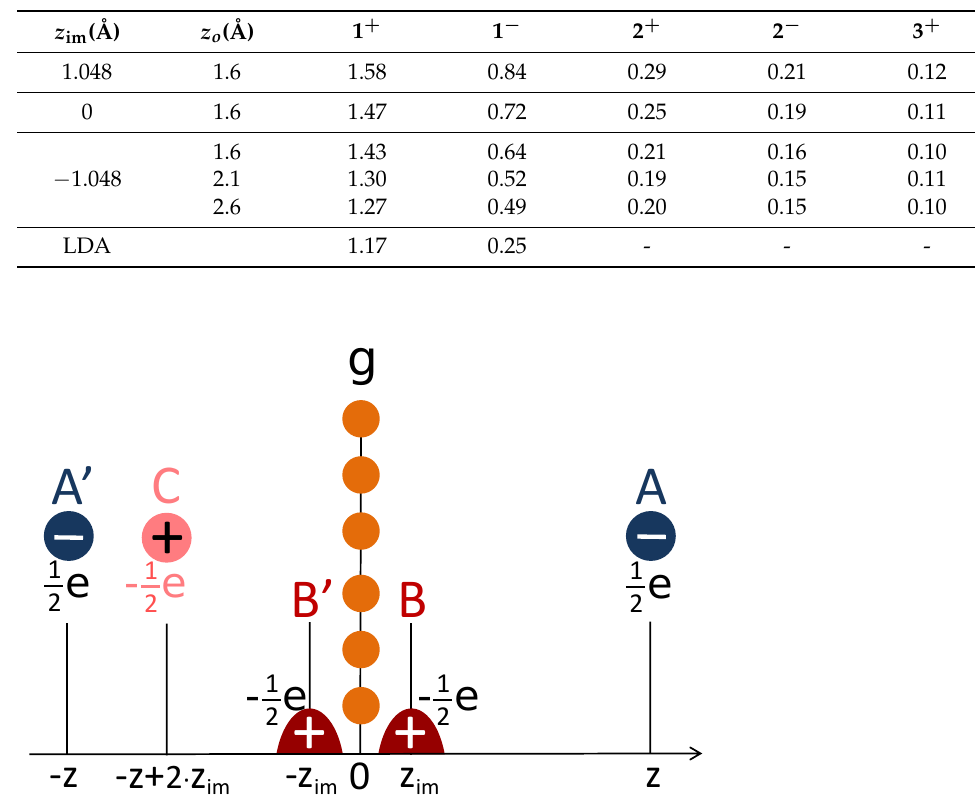
Table 1. Binding energies (in eV) of the image-potential states in graphene obtained with the hybrid potentials constructed with z o = 1.6 Å and z im = 1.048 and z im = 0 Å. In the case of z im placed at − 1.048 Å the energies are obtained for three values of the matching plane position z o . Last line presents the values of the states obtained in the LDA calculation [25].